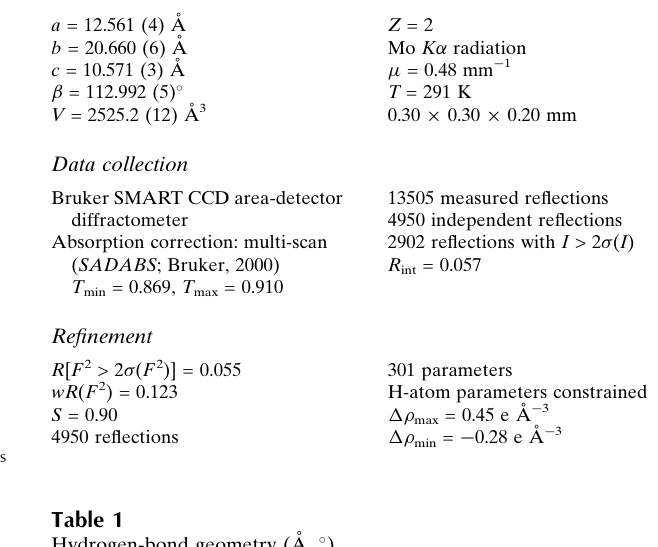
Hydrogen-bond geometry (A˚ , (cid:2)